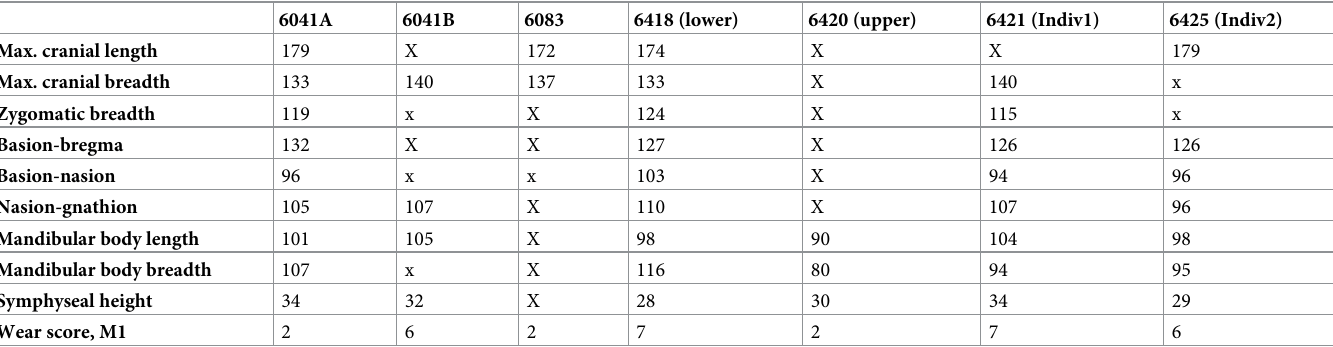
Table 2. Selected cranial measurements and dental wear scores (as per 64) of the Lagoon Beach adult skeletons